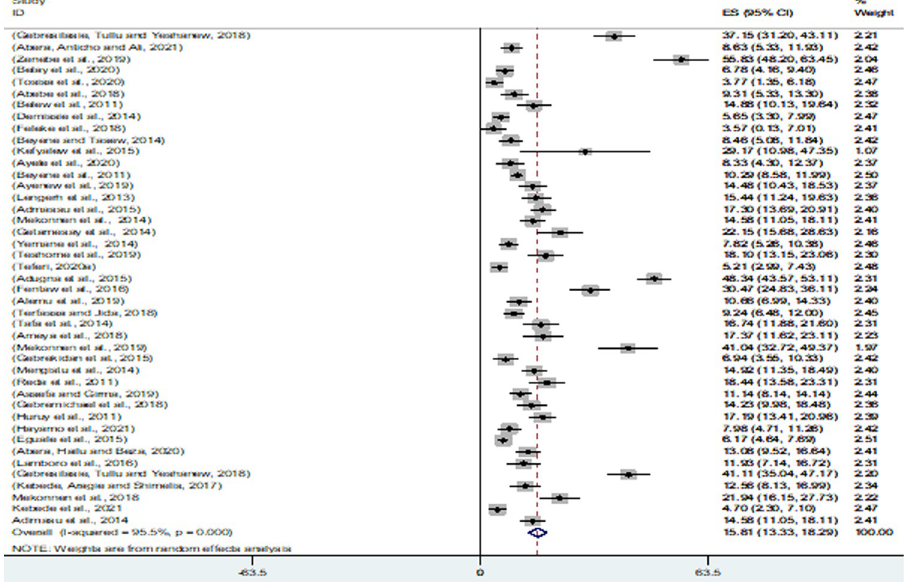
Fig 4. Forest plot of pooled prevalence estimates of Gram-negative enteric bacterial pathogens among diarrheic patients. The middle solid vertical line represents the minimum possible prevalence value (0). The dashed line represents the mean pooled prevalence estimate. The black diamond at the centre of the grey box represents the point prevalence estimate of each study and the horizontal line indicates the 95% confidence interval of the estimates. The grey box shows the weight of each study contributing to the pooled prevalence estimate. The last row represents the overall pooled prevalence estimate with a 95% confidence interval.